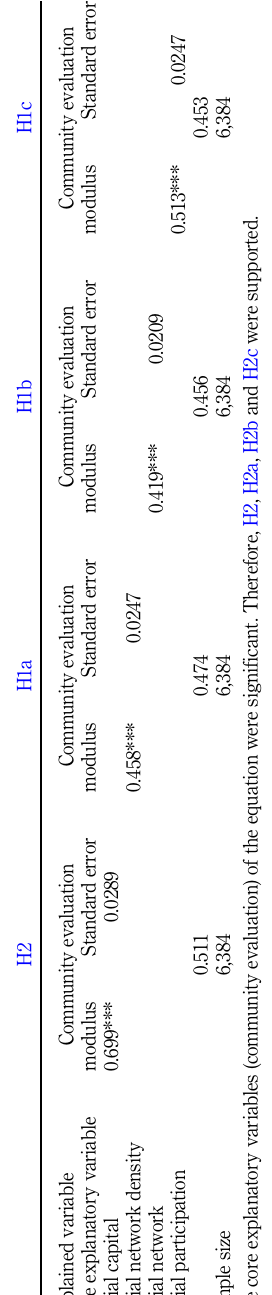
Table 7. H2 Hypothetical model test